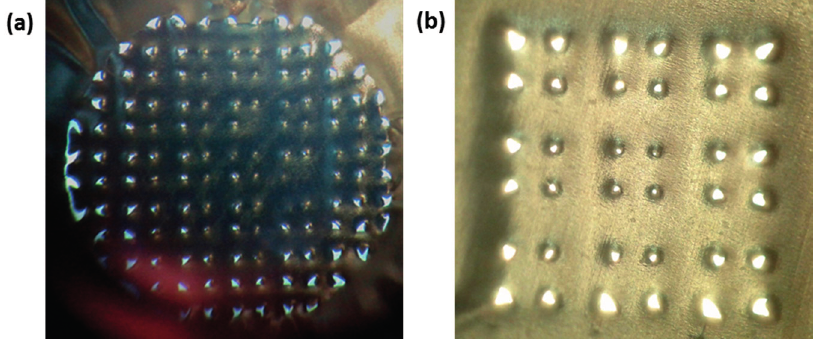
Figure 13. Evaluation of puncture efficiency for insertion of npMNAs in aluminum foil on PDMS as skin model. ( a ) Overview image of the distribution of puncture holes and imprints for G4-fc-R200 (Figure 10e); ( b ) Overview image of the distribution of puncture holes for G4-3×3-R200 depicting clearly smaller holes towards the center of the